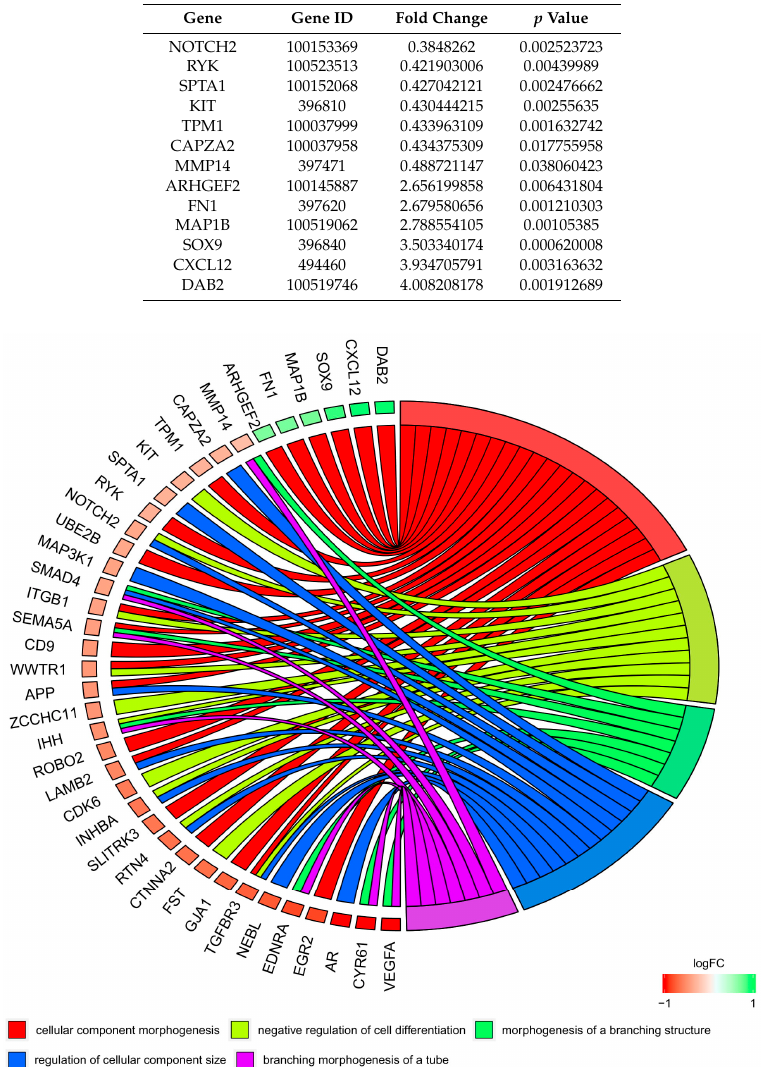
Figure 6. The representation of the mutual relationship between differently expressed genes that belong to the “cellular component morphogenesis”, “negative regulation of cell differentiation”, “morphogenesis of a branching structure”, “regulation of cellular component size”, and “branching morphogenesis of a tube” GO BP terms. The ribbons indicate the genes belonging to specific categories. The middle circle represents logarithm from fold change (LogFC). The genes were sorted by logFC by differences in gene expression. The color of the each LogFC bar corresponds to the LogFC value.